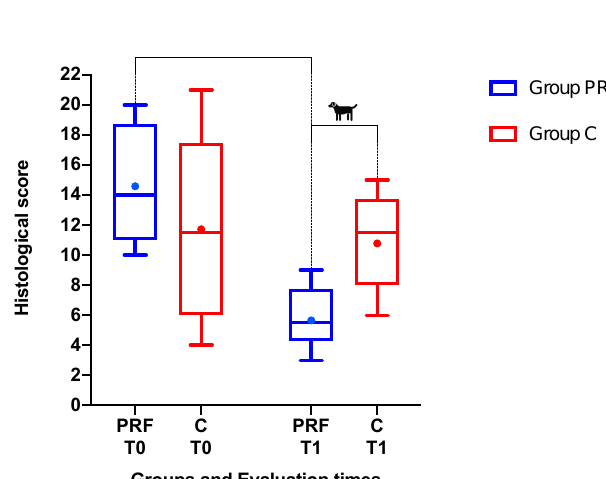
Figure 8. Boxplot showing the histological scoring system in the treated group (group PRF) and in the control group (group C) at recruitment (T0) and after a three-week follow-up (T1). The ends of the whiskers show minimum and maximum score values; boxes show the median, the first quartile, and the third quartile; red and blue dots show the mean. The blue asterisk indicates statistical significance within group PRF from T0 to T1. The black dog indicates statistical significance between groups at T1.